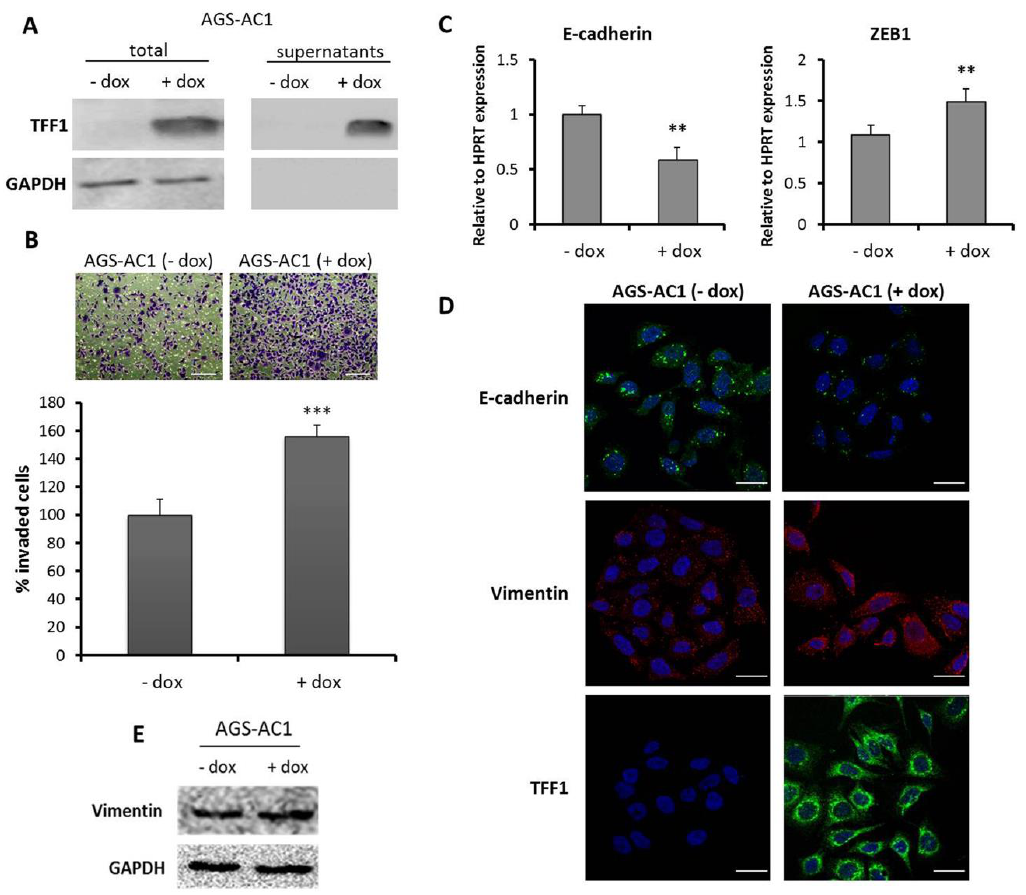
Figure 1. Trefoil factor 1 (TFF1) promotes invasion and epithelial to mesenchymal transition (EMT) changes in cellular models. ( A ) Protein level of TFF1 detected by western blotting. Protein normalization was performed on GAPDH levels; ( B ) Trans-well invasion assay of AGS-AC1 (TFF1 inducible hyperexpressing clone). Upper panel, bottom surface of filters stained with crystal violet.